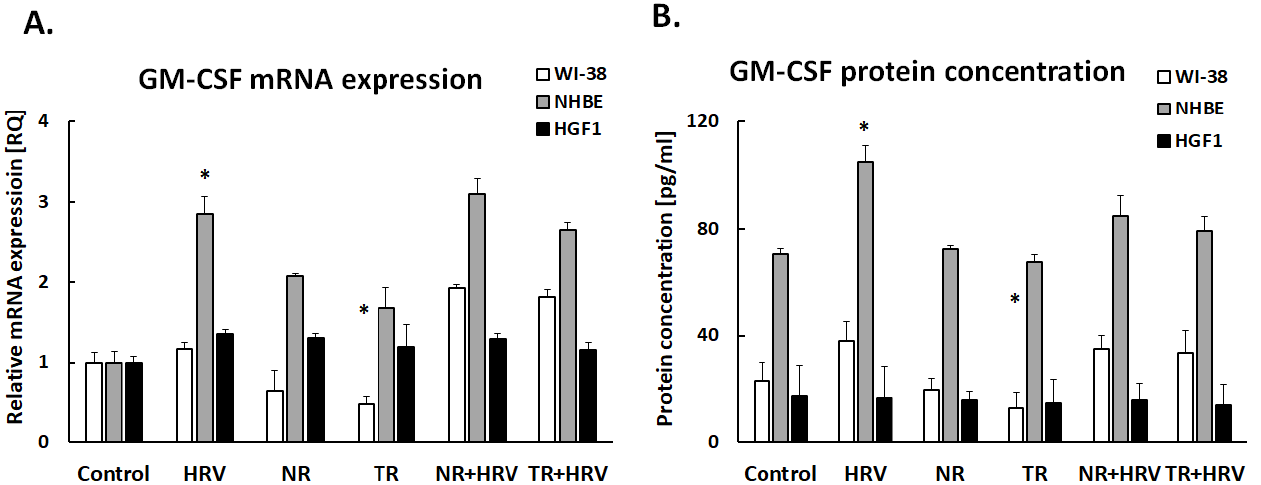
Figure 4. The effect of the Leonotis nepetifolia NR and TR root extracts and viral infection (HRV-16) on the expression of GM-CSF on mRNA ( A ) and protein ( B ) levels in human cells. Data presented as mean ± SEM, * p < 0.05.